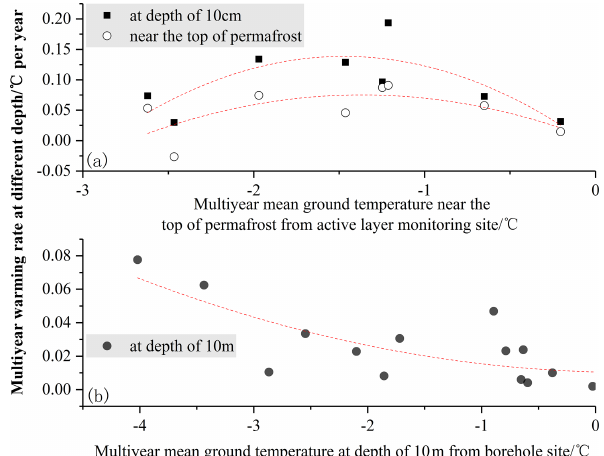
from 290 to 890 mm among our monitoring sites (Fig. 9b).